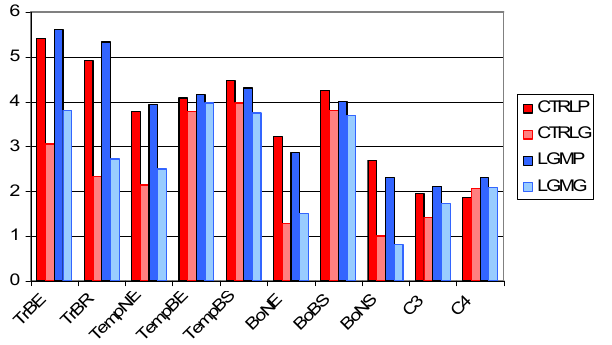
Fig. 11. Relative changes in the global mean annual net primary productivity (NPP) in CTRLG, LGMP and LGMG in % compared to CTRLP. The NPP is averaged on the grid-cells where the fraction of the PFT exceeds 1%. Abbreviations: see Table 1 for the PFTs and Table 2 for the